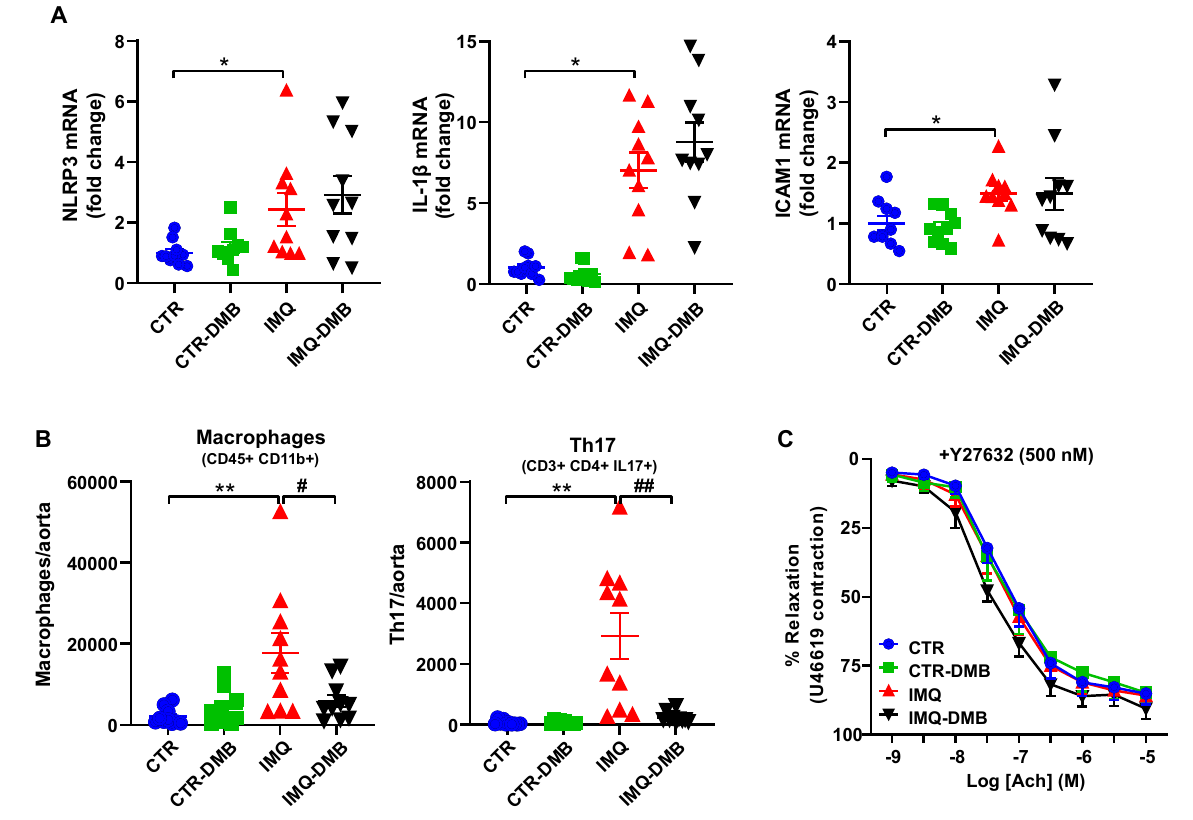
Figure 6. Role of NLRP3 pathway and immune cells infiltration in TMAO-induced endothelial dysfunction in imiquimod (IMQ) animals. ( A ) Aortic mRNA levels of NLRP3 and downstream IL-1 β and ICAM1 measured by RT-PCR. ( B ) Th17 and Th1 cells as detected with flow cytometry in aorta. ( C ) Acetylcholine (Ach)-induced relaxation responses in aortas pre-contracted by U46619 (10 nM), with or without the specific Rho kinase inhibitor Y27632 (500 nM). Groups: control (CTR), CTR-group treated with 3,3-dimethyl-1-butanol (DMB) (CTR-DMB), IMQ, and IMQ-group treated with DMB (IMQ-DMB). The data are represented as means ± SEM. The concentration–response curves to Ach were analyzed by two-way ANOVA with the Tukey’s multiple comparison test. One-way ANOVA and Tukey’s multiple comparison test were performed. * p < 0.05 and ** p < 0.01 when compared to CTR; # p < 0.05 and ## p < 0.01 when compared to